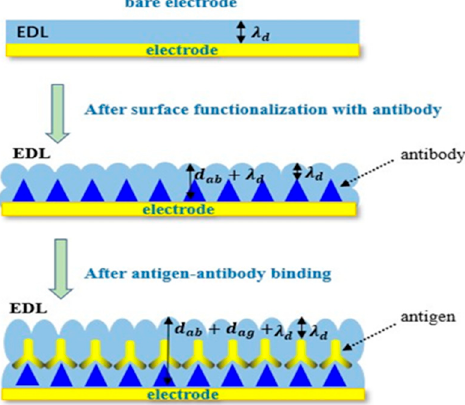
Figure 4. Changes on the electrode surface due to the specific binding of antigens to antibodies.